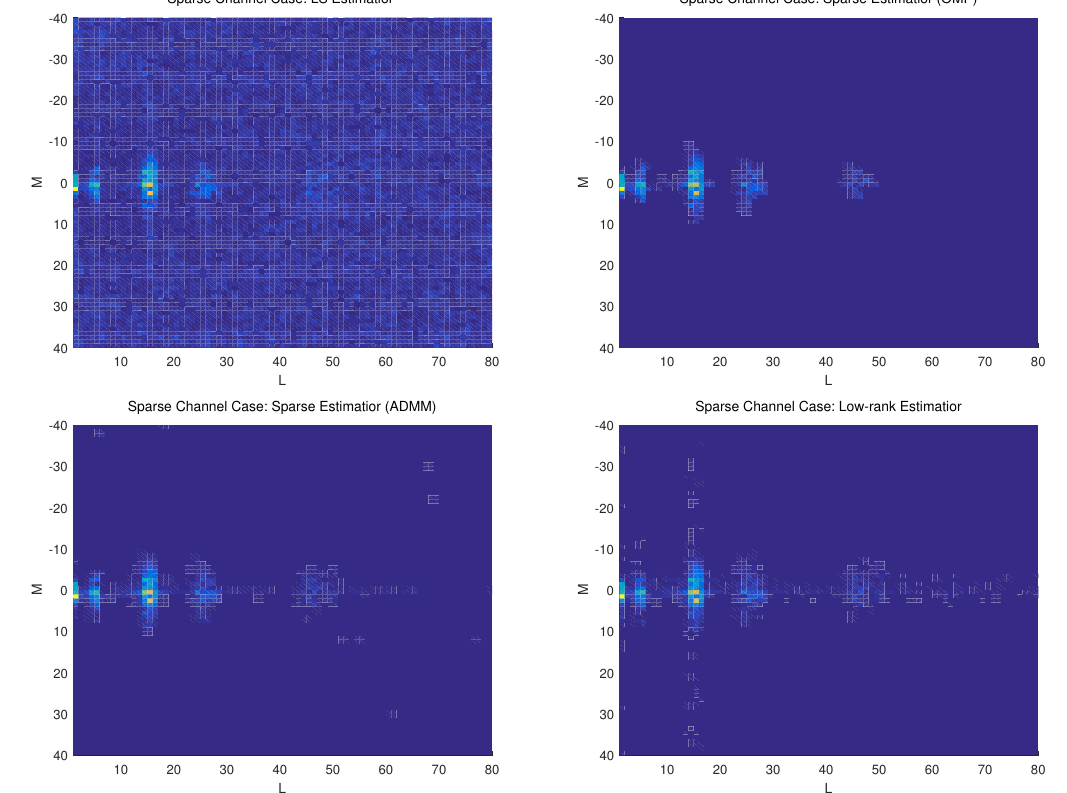
Figure 3. DDSM estimated by different estimators under sparse channel case. ( a ) LS method; ( b ) Sparsity-based Method; ( c ) Low-rank-based